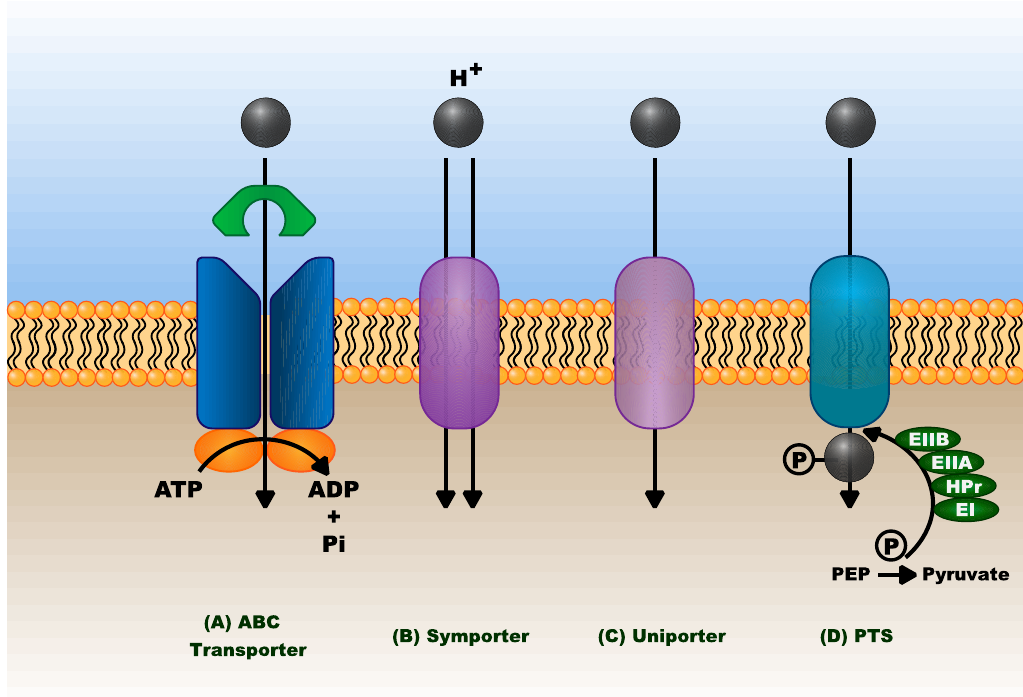
Figure 6. Microbial sugar transporters. Sugar can be transported across the cell membrane via an adenosine triphosphate (ATP) dependent, four-protein ATP-binding cassette (ABC) transporter (A), a single transmembrane protein proton symporter (B), a single transmembrane protein uniporter (C), or a phosphotransferase system (PTS) transporter, which requires a phosphorylation cascade generated from the conversion of phosphoenolpyruvate (PEP) to pyruvate (D).